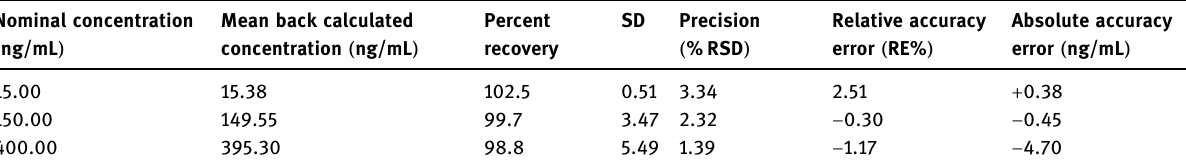
*Average of six determinations.